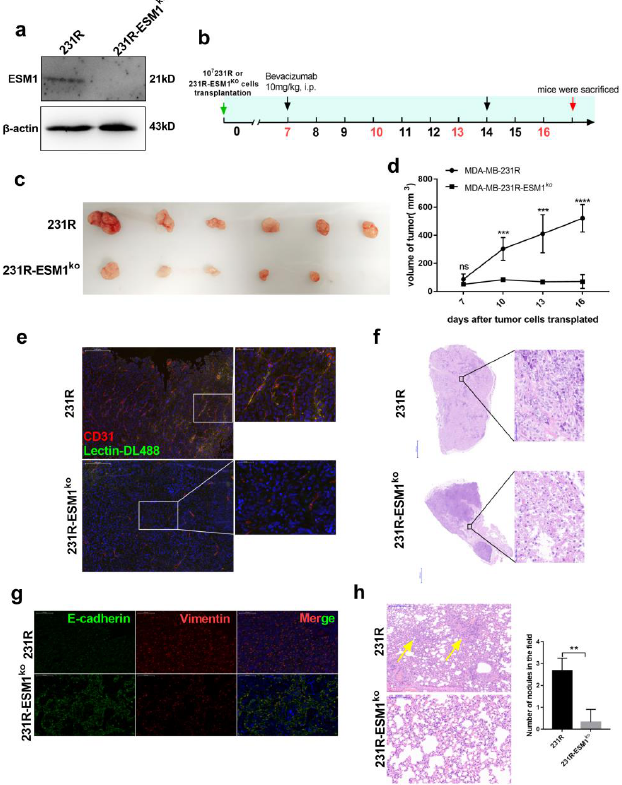
Figure 7. ESM1 deletion in bevacizumab resistant cells and in vivo experiment. ( a ) Western blotting for analyzing the expression of ESM1 deleted or not by the Crispr − Cas9 system in MDA − MB − 231 − R cells (Figure S6). ( b ) Schematic of experimental design for MDA − MB − 231 − R or MDA − MB − 231 − R − ESM1 ko − bearing mice model treated with bevacizumab. ( c , d ) Tumor growth volume and photos over time following subcutaneous transplant of MDA − MB − 231 − R or MDA − MB − 231 − R − ESM1 ko cells into balb/c − nude mice. *** p < 0.001; **** p < 0.0001 by two − way ANOVA test. ( e ) Representative images of tumor sections from mice treated with bevacizumab. CD31 was co − stained with DL488 −labeled Lectin and nucleus. Scale bar, 200 μm (left) and 50 μm (right). ( f ) Representative H&E staining image of tumor sections from mice treated with bevacizumab. Scale bar, 2000 μm (left) and 50 μm (right). ( g ) Representative images of tumor sections from MDA − MB − 231 − R or MDA − MB − 231 − R − ESM1 ko − bearing mice treated with bevacizumab. Vimentin was co − stained with E −cadherin and nucleus. Scale bar, 200 μm. ( h ) Representative images and statistical analysis of HE staining to assess the number of lung metastasis in the different treatment group; scale bar, 200 μm, ** p < 0.01 by t test.